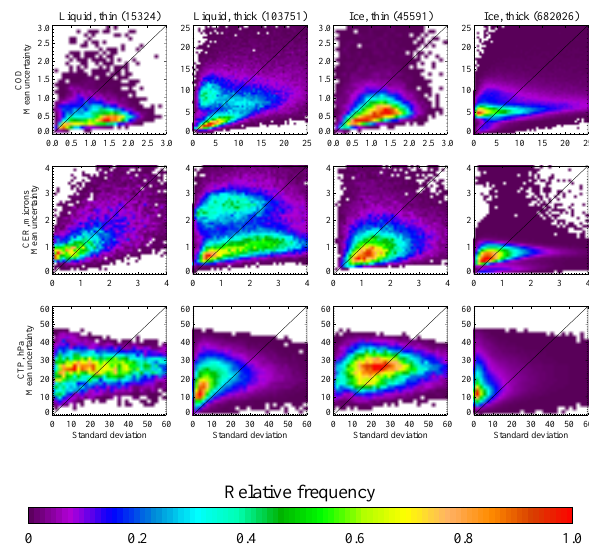
Fig. 6. As Fig. 5, except for clouds over land. that for τ c < 10 the COD and CER uncertainty estimates are too small by a factor of approximately 2, while the CTP un- dard deviations but are only weakly linked to the apparant